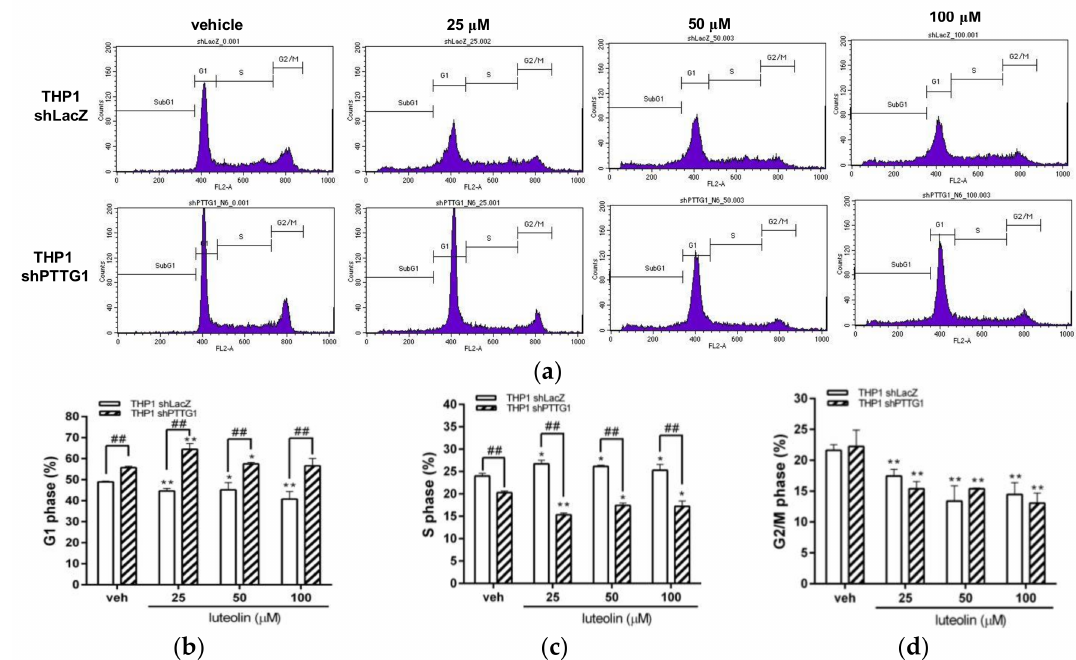
Figure 6. Effects of luteolin on cell-cycle distribution in PTTG1-knockdown cells. The THP1 shLacZ and shPTTG1 cells were treated with vehicle or luteolin (25–100 µ M) for 24 h. ( a ) The cell-cycle distribution was determined by flow cytometric analysis. The experiments were replicated three times. A representative histogram is shown. Cell populations in the ( b ) G1 phase ( c ) S phase ( d ) G2/M phase were quantified. The experiments were replicated at three times. The data are presented as the means ± SD from three independent experiments. * p < 0.05 and ** p < 0.01 indicate a significant difference compared to the vehicle group (veh). ## p < 0.01 represents a significant difference compared to the THP1 shLacZ control